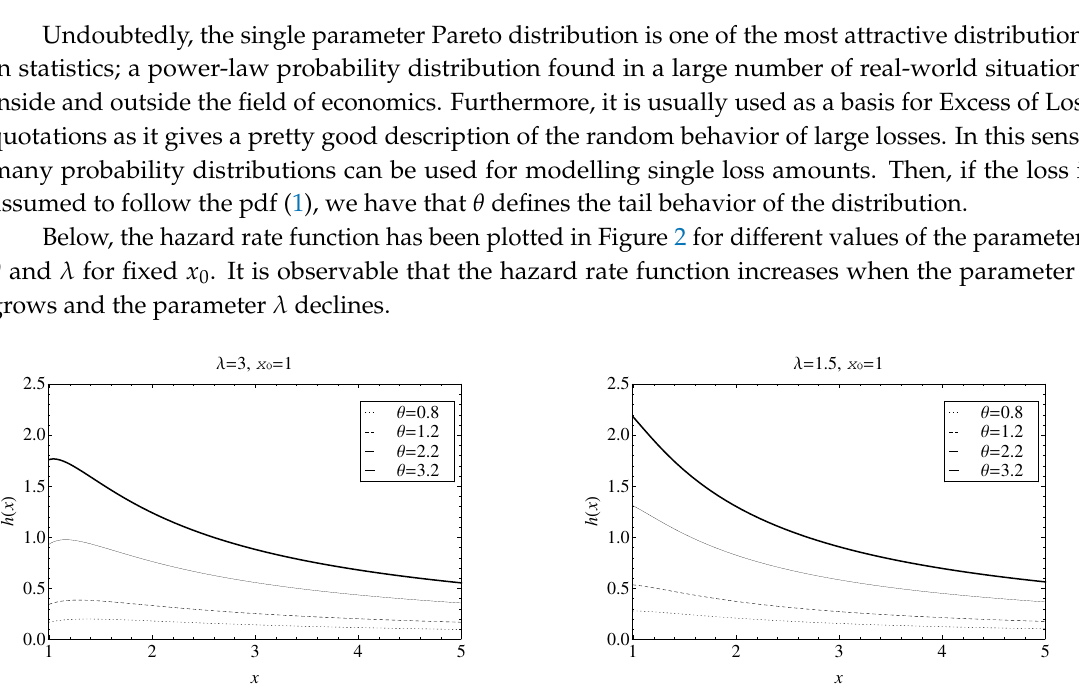
Figure 1. Graphs of the pdf (1) for different values of parameter θ , λ and fixed value of x 0 .